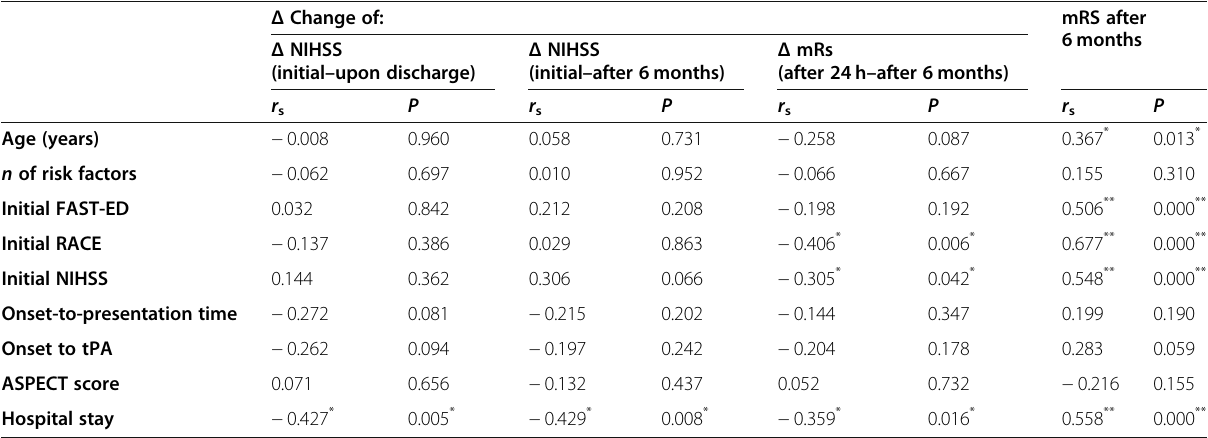
Table 4 Correlation between patients ’ age, initial stroke assessment scales, onset-to-tPA and hospital stay durations, and the functional outcome of AIS